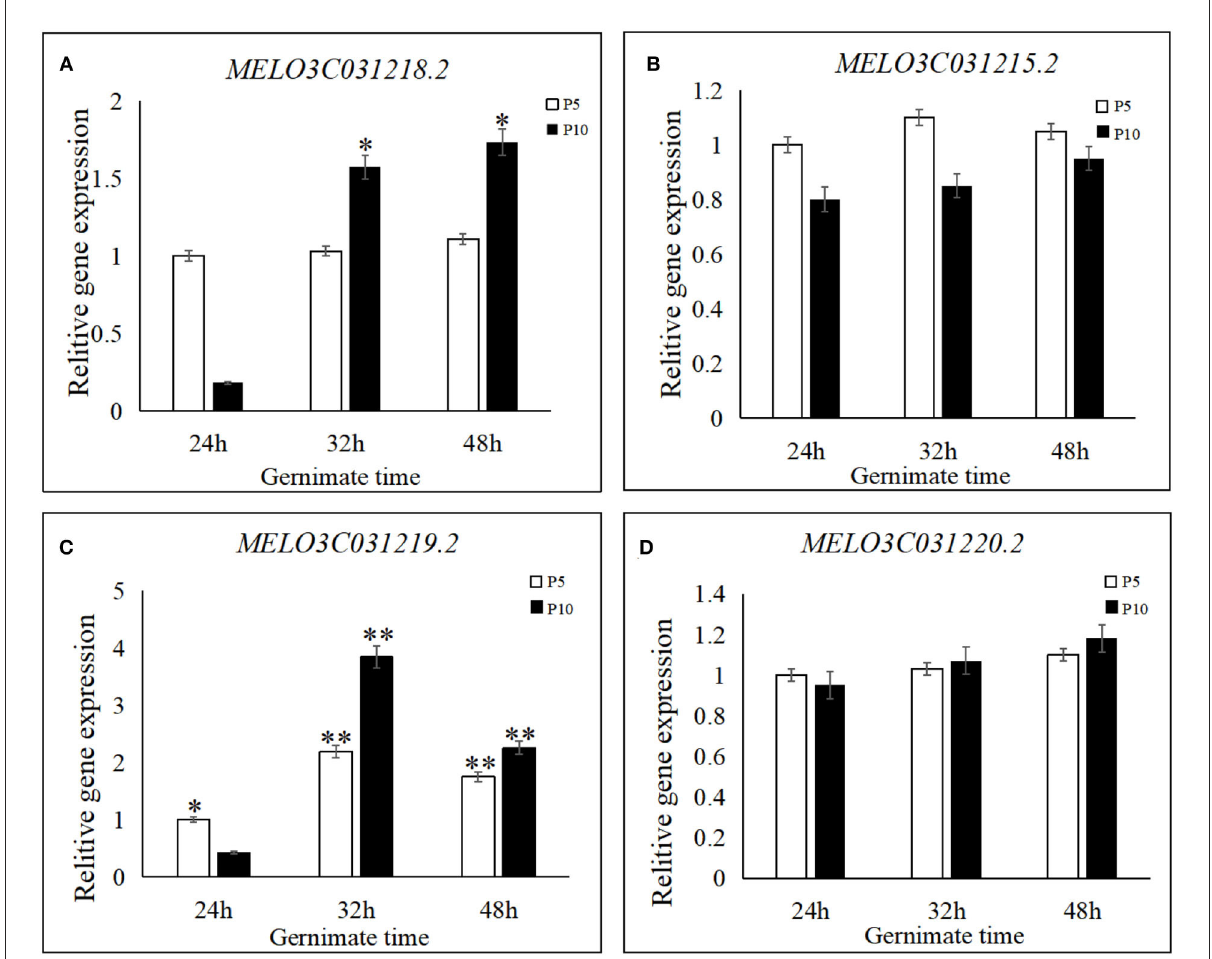
FIGURE5 Relative expression levels of four candidate genes in seed germination for “P5” and “P10.” (A) Expression levels of MELO3C031218.2 , (B) expression levels of MELO3C031215.2 , (C) expression levels of MELO3C031219.2 , and (D) expression levels of MELO3C031220.2 . Candidate genes were quantified using the 2 − 11 CT method. For the two parents, the expression level of the respective genes at 24, 32, and 48h after germination following treatment by 8-h soaking at 28 ◦ C. Each experiment was repeated three times, and 15 plants were mixed in equal amounts to form one replicate in two parents. **indicates an extremely significant difference, P < 0.01; *indicates a significant difference, P < 0.05.